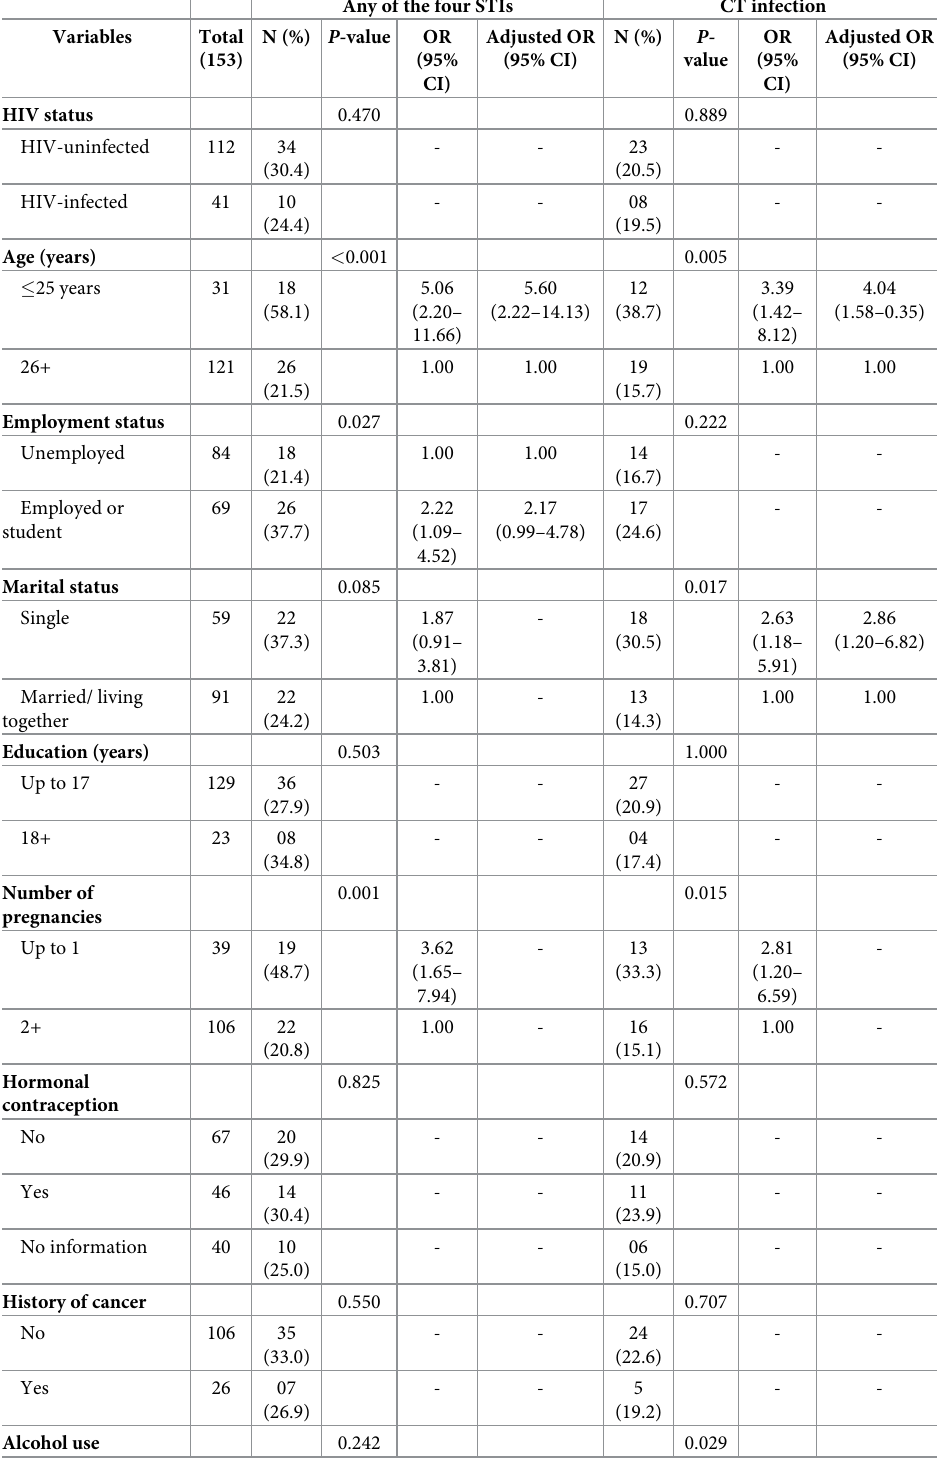
Table 5. Univariate and multivariate analyses of risk factors for any STI or CT infection in HIV-uninfected and HIV-infected